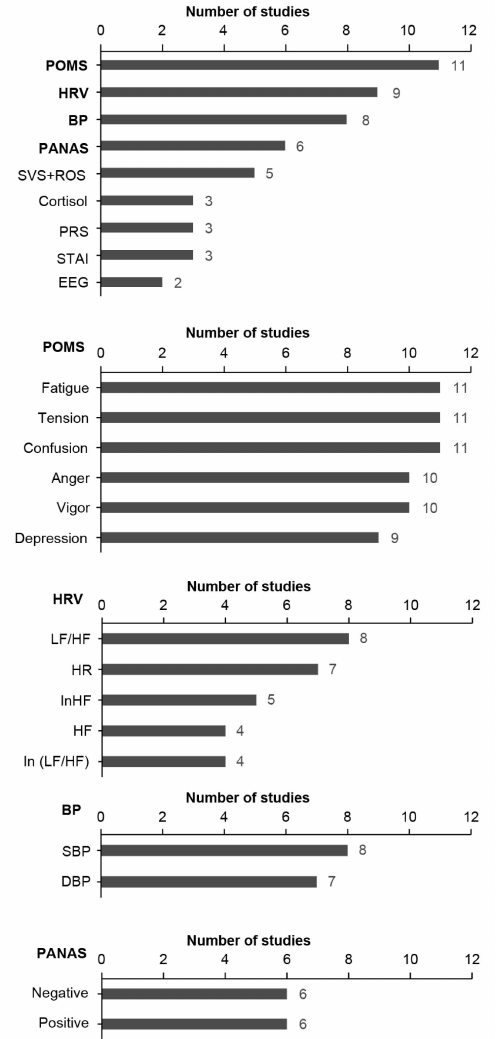
Figure 3. The number of studies that measured different outcome variables (total number of stud- ies = 24). POMS: Profile of Mood States; HRV: Heart Rate Variability; BP: Blood Pressure; PANAS: Positive and Negative; SVS: Subjective Vitality Scale; ROS: Restorative Outcome Scale; PRS: Perceived Restorative Scale; STAI: State-Trait Anxiety Inventory; EEG: Electroencephalogram; HR: Heart Rate; HF: High Frequency omponent of heart rate variability; LF: Low Frequency component of heart rate variability; SBP: Systolic Blood Pressure; DBP: Diastolic Blood